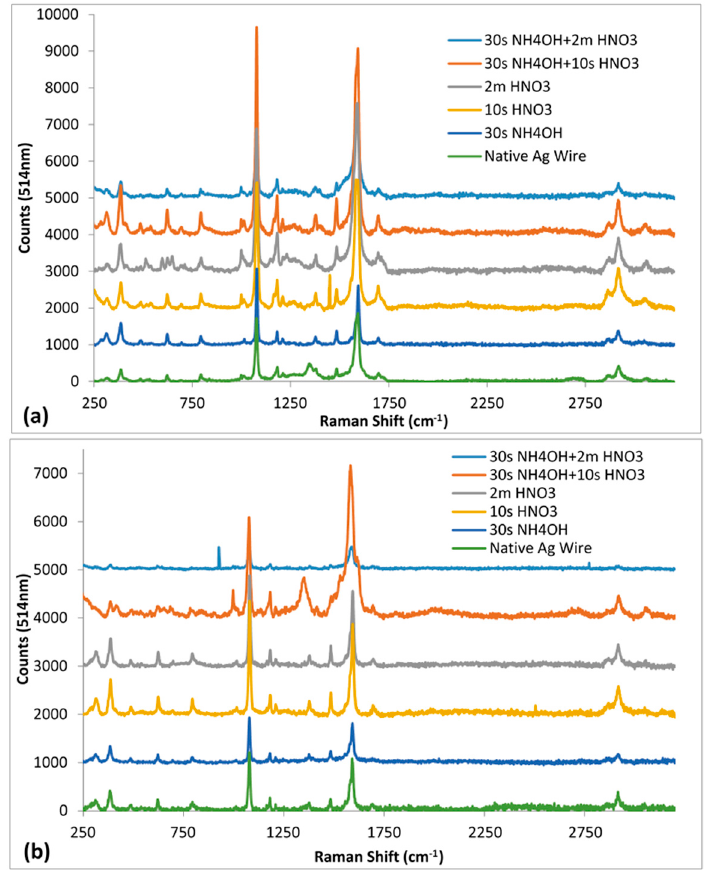
Figure 7. The 514 nm Raman spectra for the native and chemically treated Ag wires with 1 mM MBT: ( a ) non-heated; and ( b ) heated. Spectra offset for clarity.